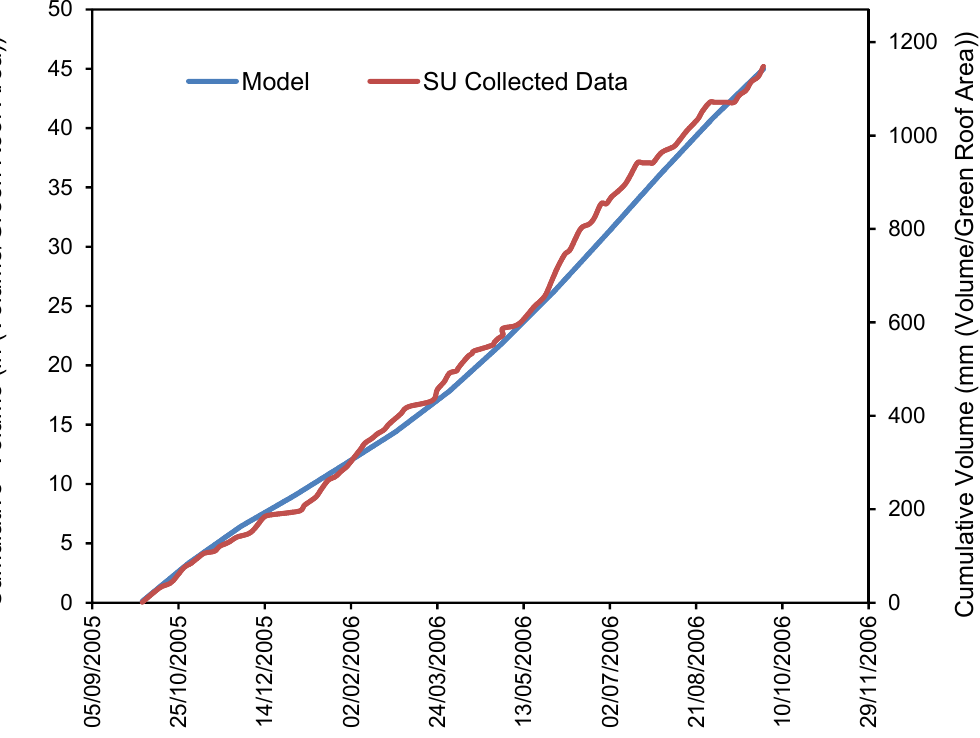
Figure 4. Comparison of cumulative ET determined from the Blaney and Criddle equation and actual data collected from a full sized operating green roof